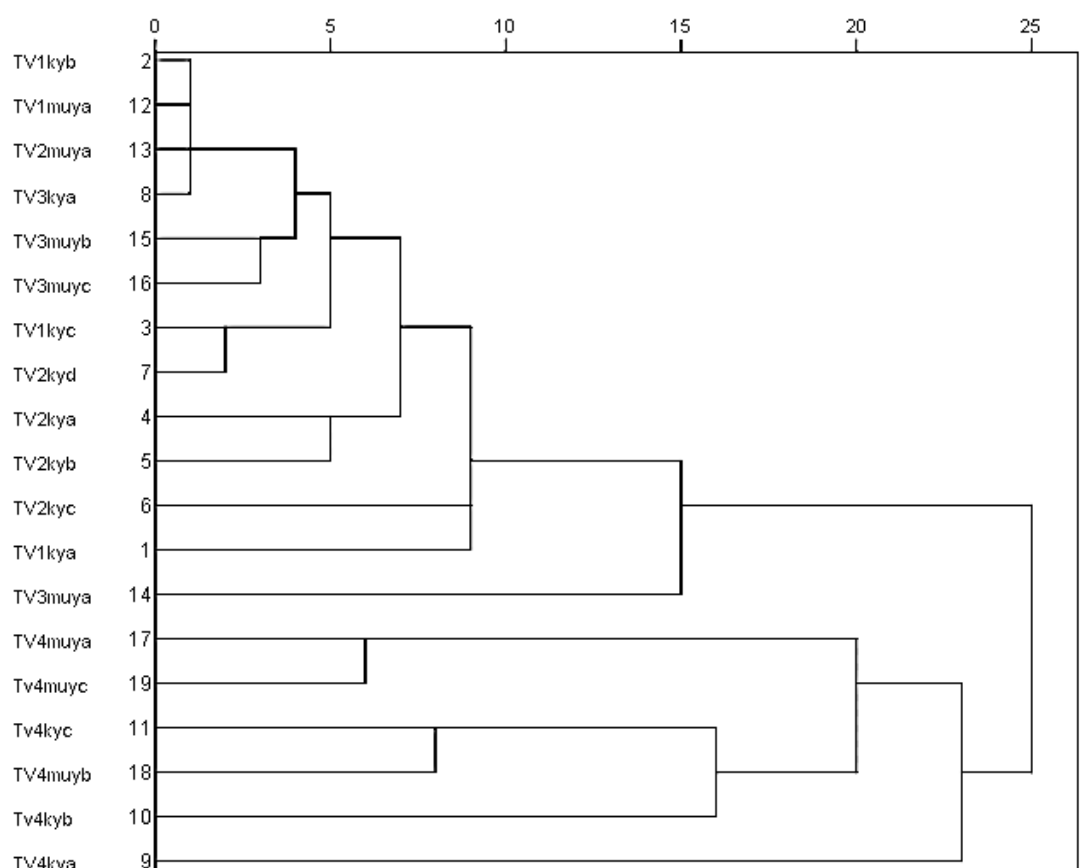
Figure 4. Dendrogram of samples due to classification based on their major composition.